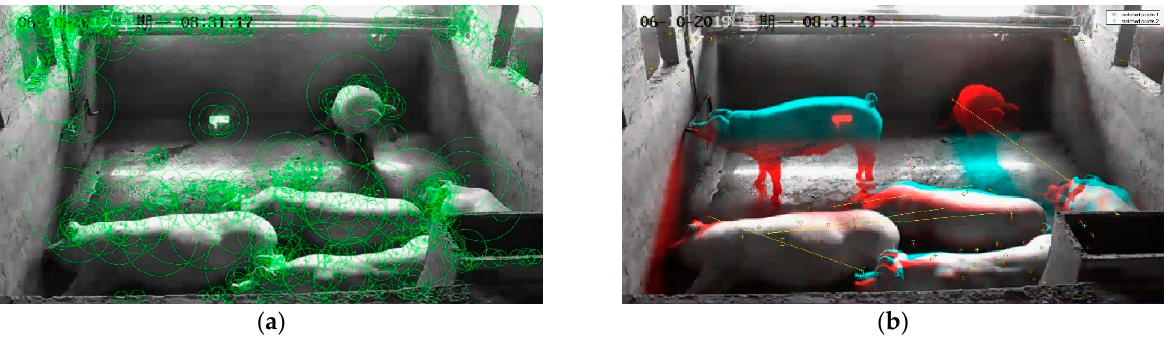
Figure 3. Video feature analysis based on Scale Invariant Feature Transform. ( a ) Feature extraction; ( b ) image analysis.